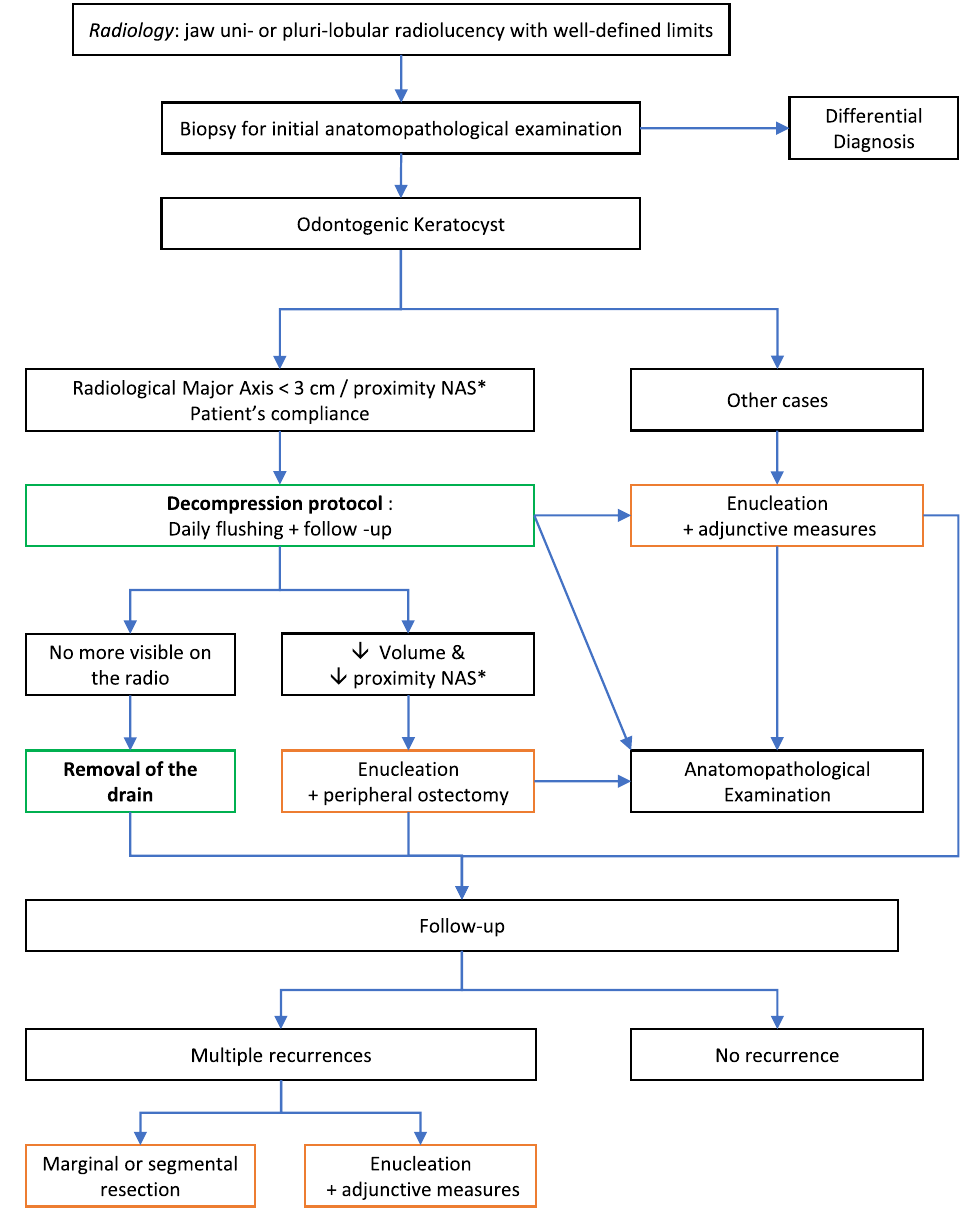
Fig. 4. Decision tree. *Noble anatomical